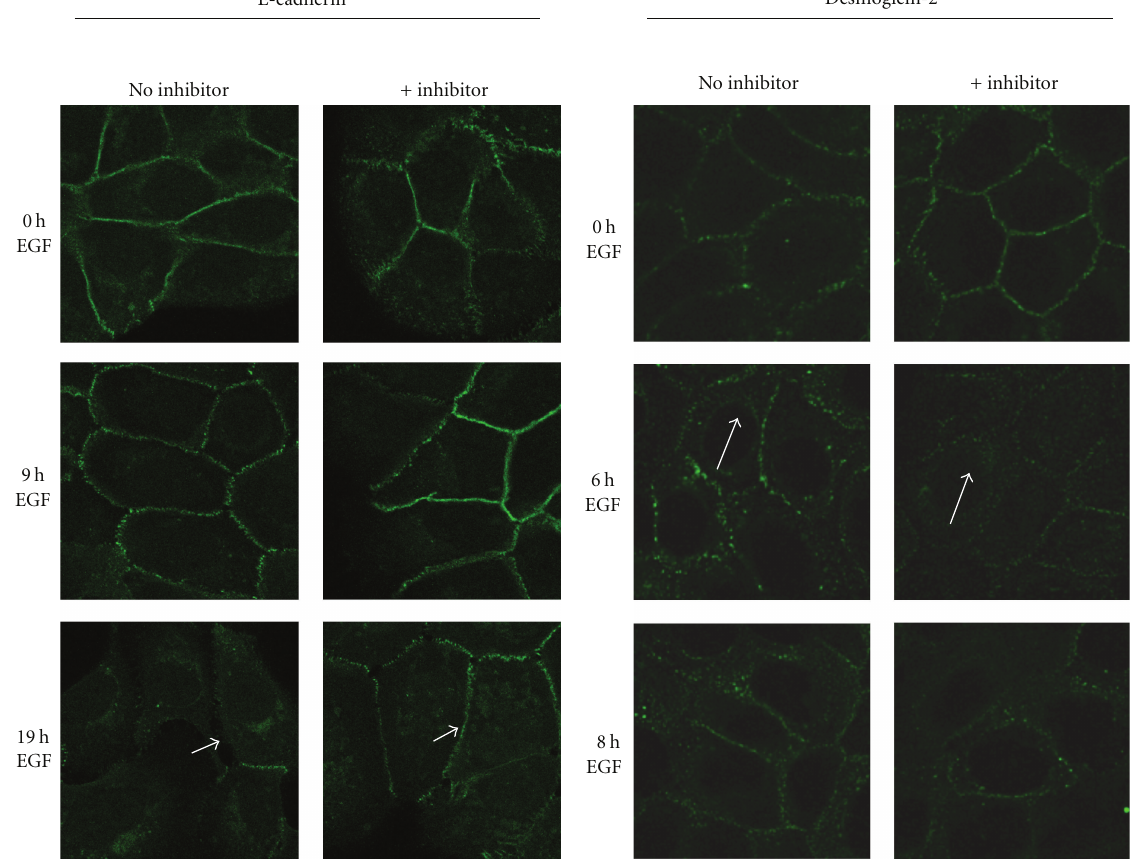
(b) Figure 9: E ff ect of MMP inhibition on membrane localization of E-cadherin or desmoglein-2 after EGF treatment. Cells were serum-starved for 24 hours then treated with 50 μ M of the broad spectrum MMP inhibitor GM6001X for 30 minutes before addition of 20nM EGF for the indicated times. Cells were then fixed and probed with either an E-cadherin antibody that recognizes the intracellular epitope or desmoglein- 2 antibody. White arrows indicate the internalized desmoglein-2 even in the presence of inhibitor, while the white arrowheads indicate the retention of E-cadherin at the cell-cell